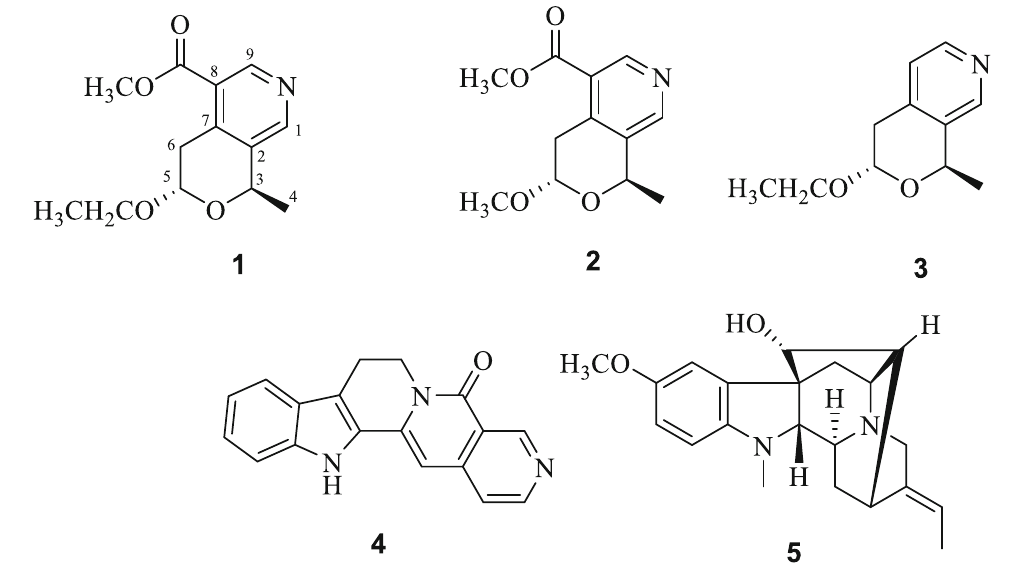
Fig. 1 Structures of compounds 1 –